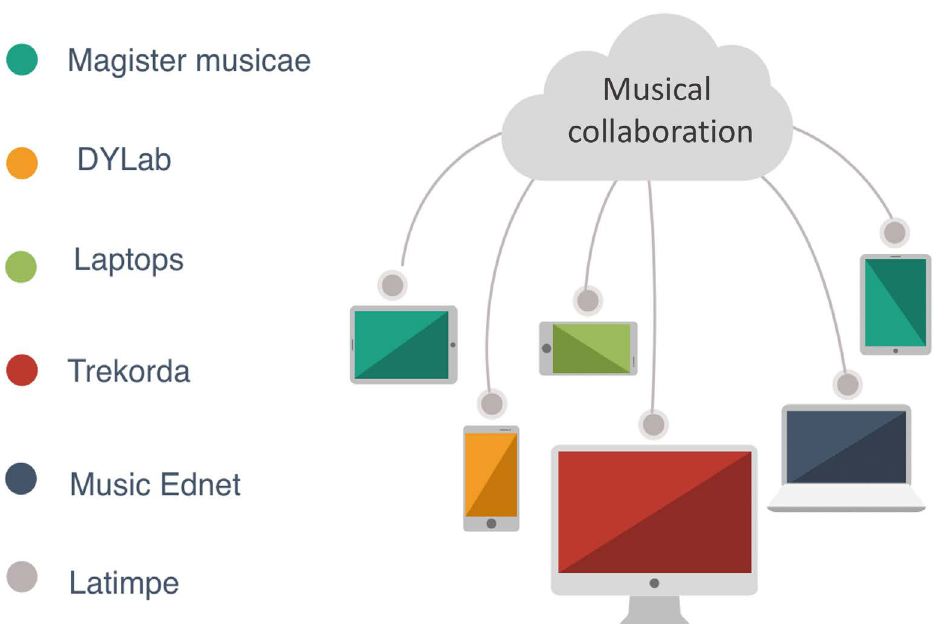
Figure 5. Examples of musical collaboration. Source: